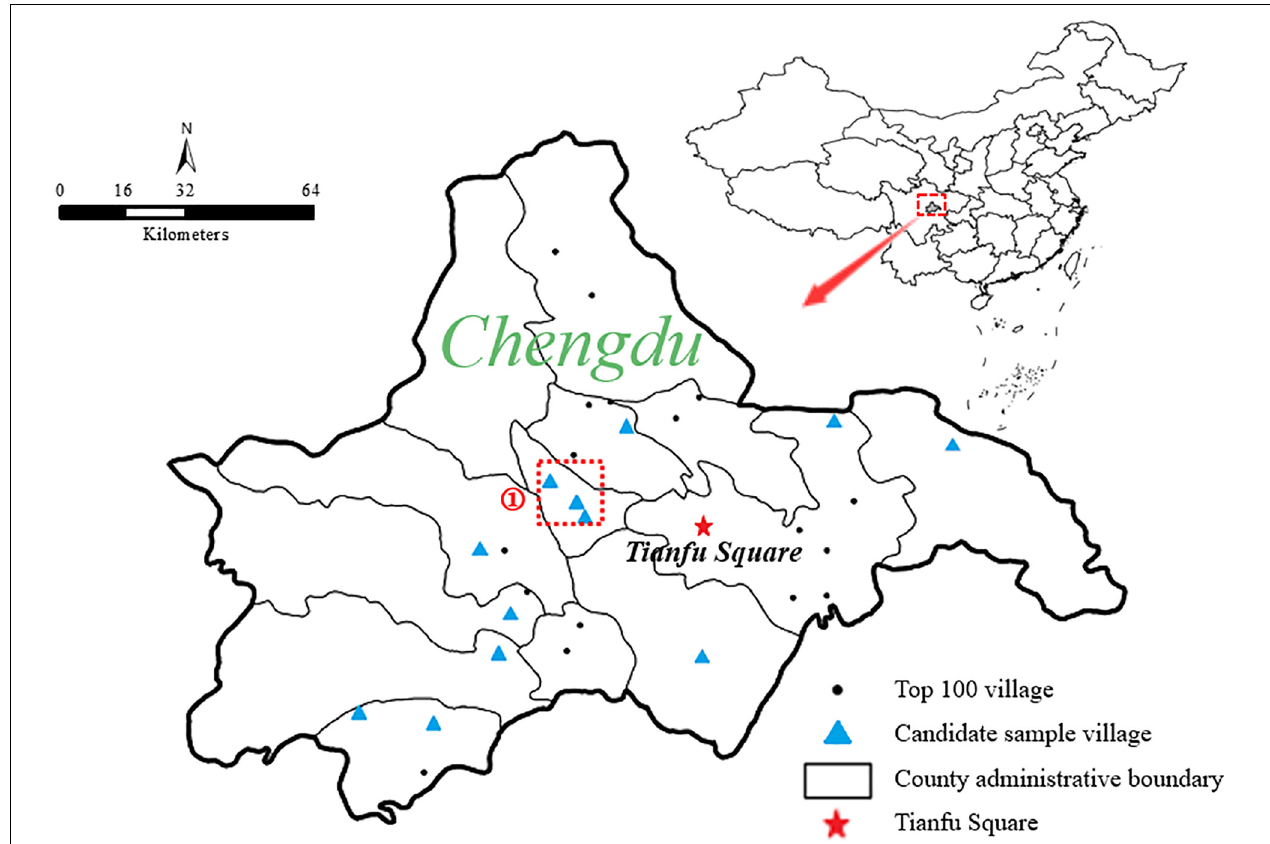
FIGURE 3 | Geographical distribution of first randomly selected sample